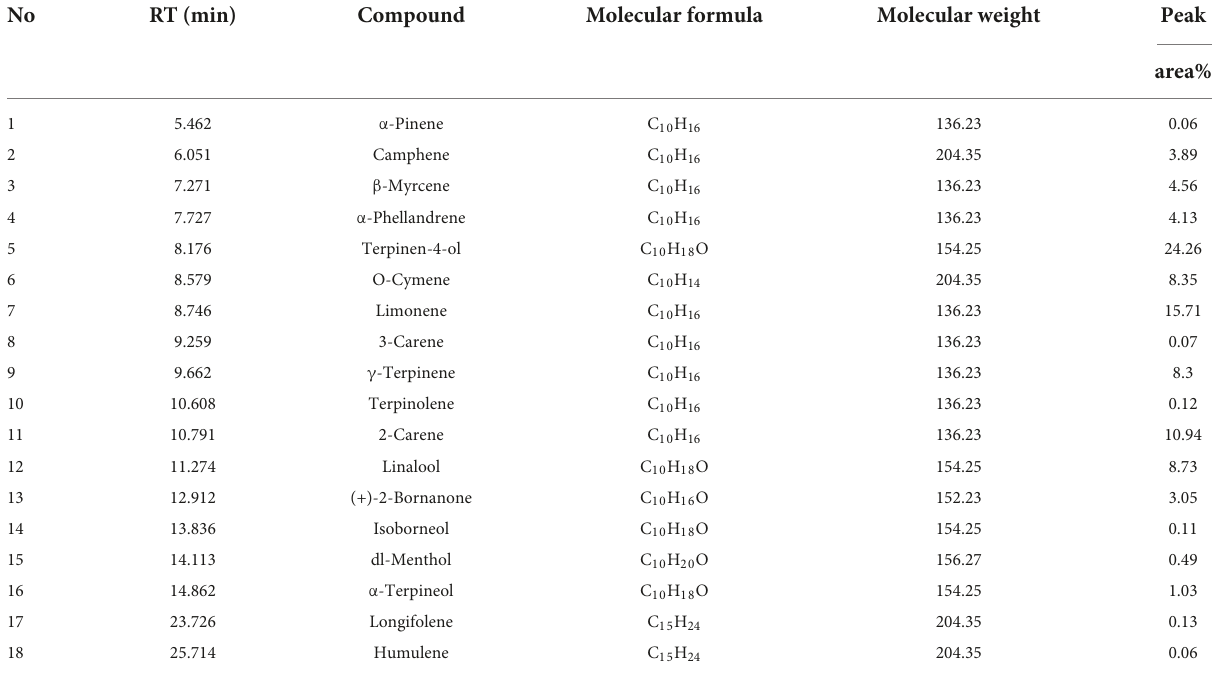
TABLE 2 GC-MS analysis of